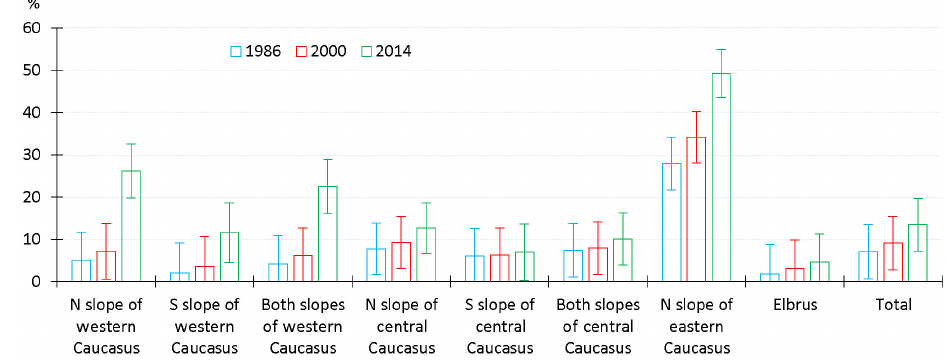
Figure 3. Percentage of supra-glacial debris cover in the Greater Caucasus for 1986, 2000 and 2014 by regions (glaciers are non-existent on southern slopes of the eastern Greater